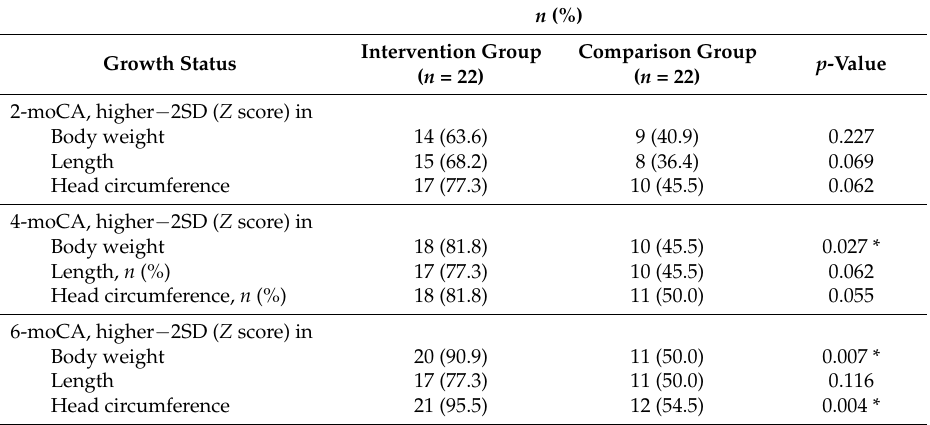
Table 7. Comparisons of growth status of preterm infants between the